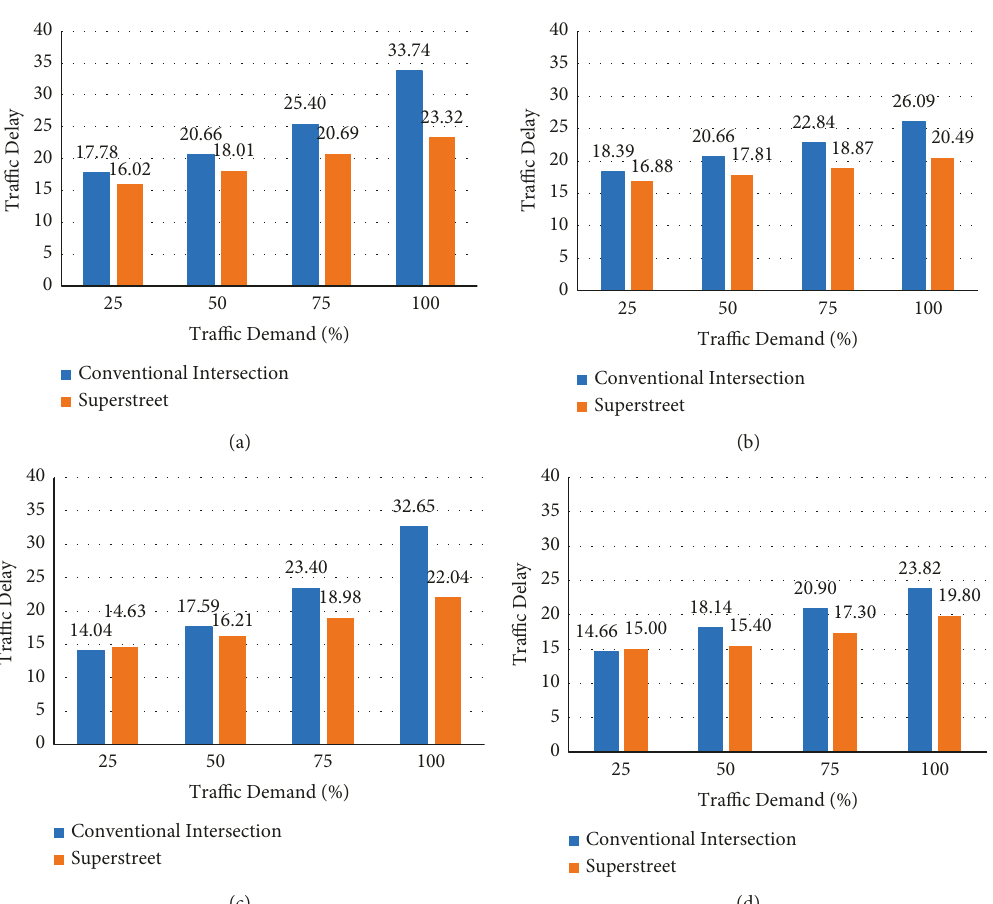
Figure 13: Average traffic delay(s) comparison of CAVs between the conventional intersection and superstreet. (a) IDM. (b) IDM with platooning. (c) IDM with trajectory planning. (d) IDM with platooning-based trajectory